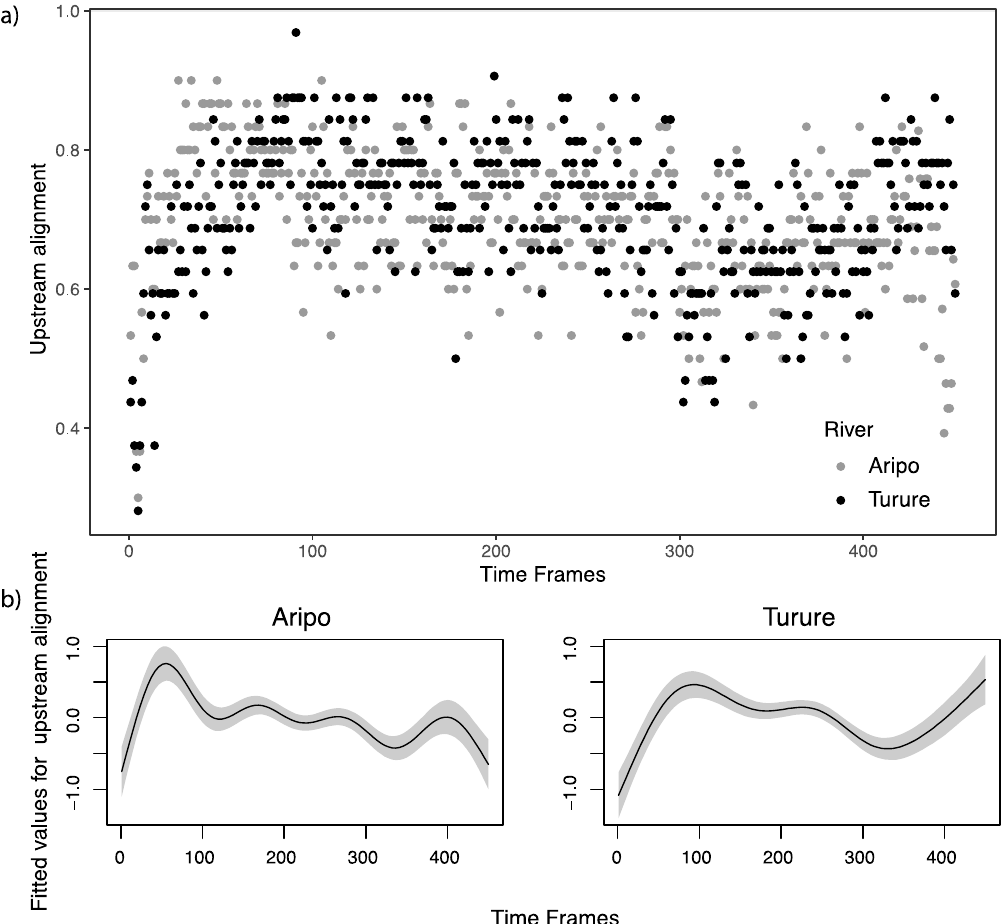
Figure 5. Values for alignment of the fish against the flow during the entire duration of the trial (450 time frames = 5 min). ( a ) Raw values for the two rivers. Maximum value (1) means that all fish were aligned with the flow, minimum value (0) means that none of the fish were aligned with the flow for that time frame. ( b ) Fitted values with GAM for the two rivers, the grey areas represent 95% confidence bands. Values are centered around 0.